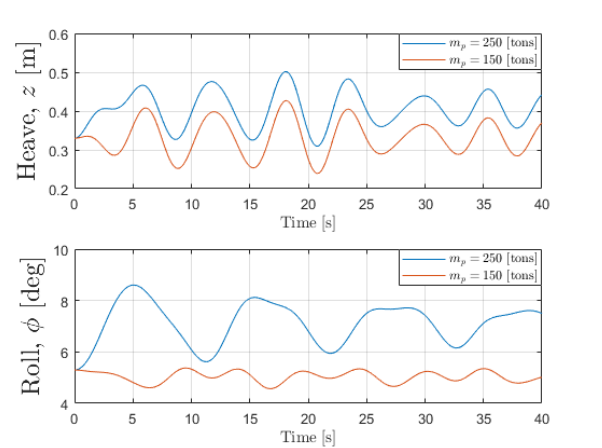
Figure 7: Upper window: The red graph represents the heave z of the vessel due to payload weight m 5 = 150 metric tons. The blue graph represents the heave z of the vessel due to payload weight m 5 = 250 metric tons. Lower window: The red graph represents the roll φ of the vessel due to payload weight m 5 = 150 metric tons. The blue graph rep- resents the roll φ of the vessel due to payload weight m 5 = 250 metric